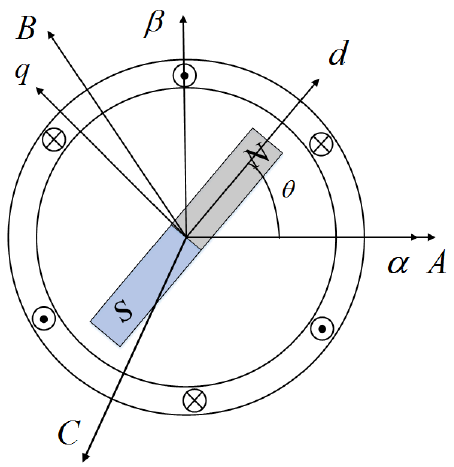
Figure 1. Illustration of the salient-pole permanent magnet synchronous motor (PMSM)